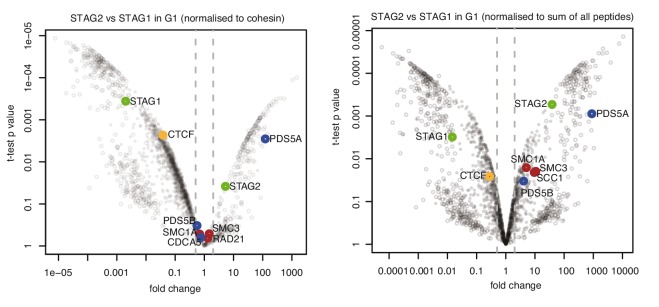
CTCF is enriched in cohesinSTAG1 immunoprecipitation Volcano plots of label‐free qMS data, representing protein abundance in STAG2 immunoprecipitates relative to protein abundance in STAG1 immunoprecipitates.Area to the left of the grey dashed line denotes proteins significantly over‐represented in STAG1 immunoprecipitates relative to STAG2 immunoprecipitates; vice versa is shown on the right. Left panel shows normalization relative to cohesin peptides and right panel shows normalization relative to the sum of all peptides.